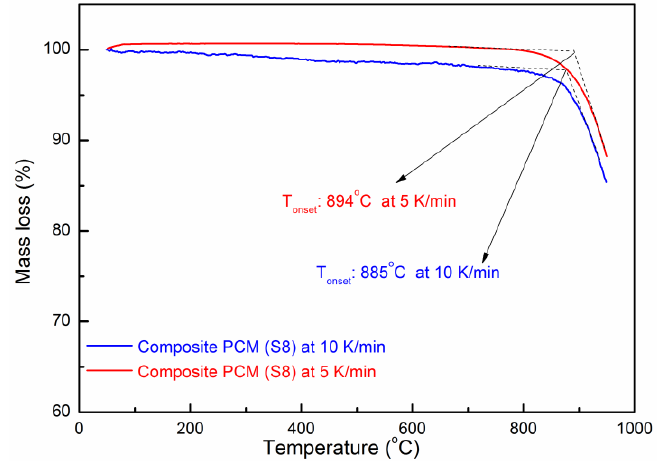
Figure 9. TG curve of the composite PCM.